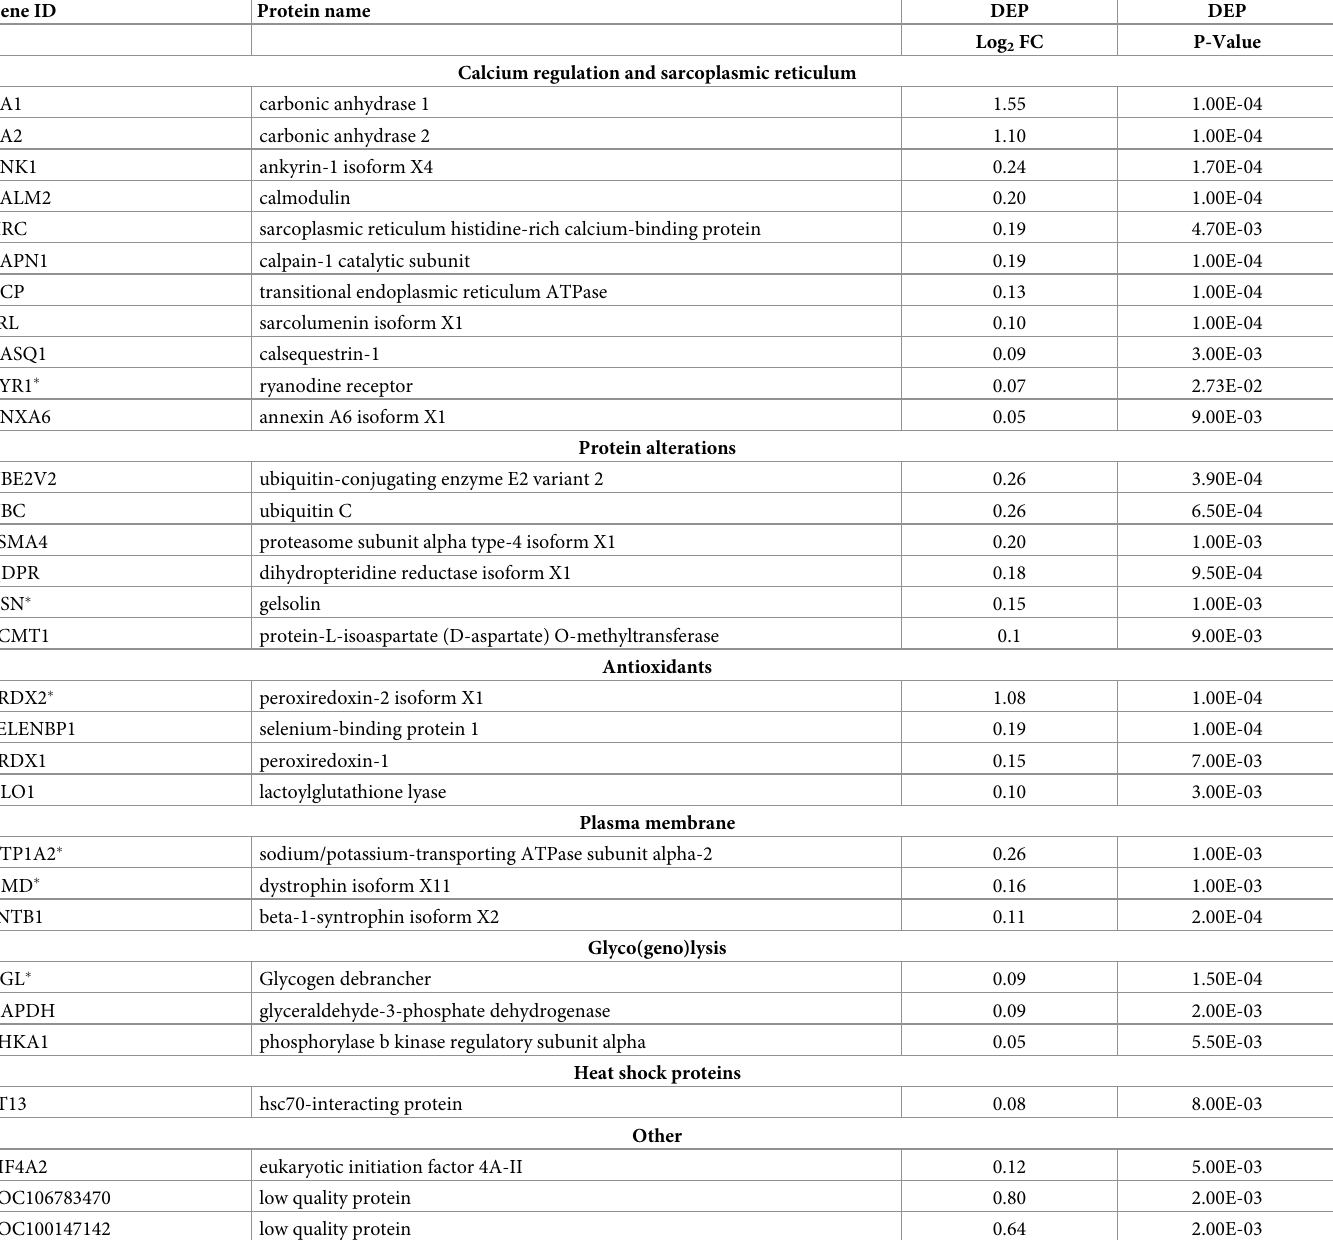
Table 2. Differentially expressed muscle proteins (DEP) with increased expression comparing horses susceptible to recurrent exertional rhabdomyolysis with control.